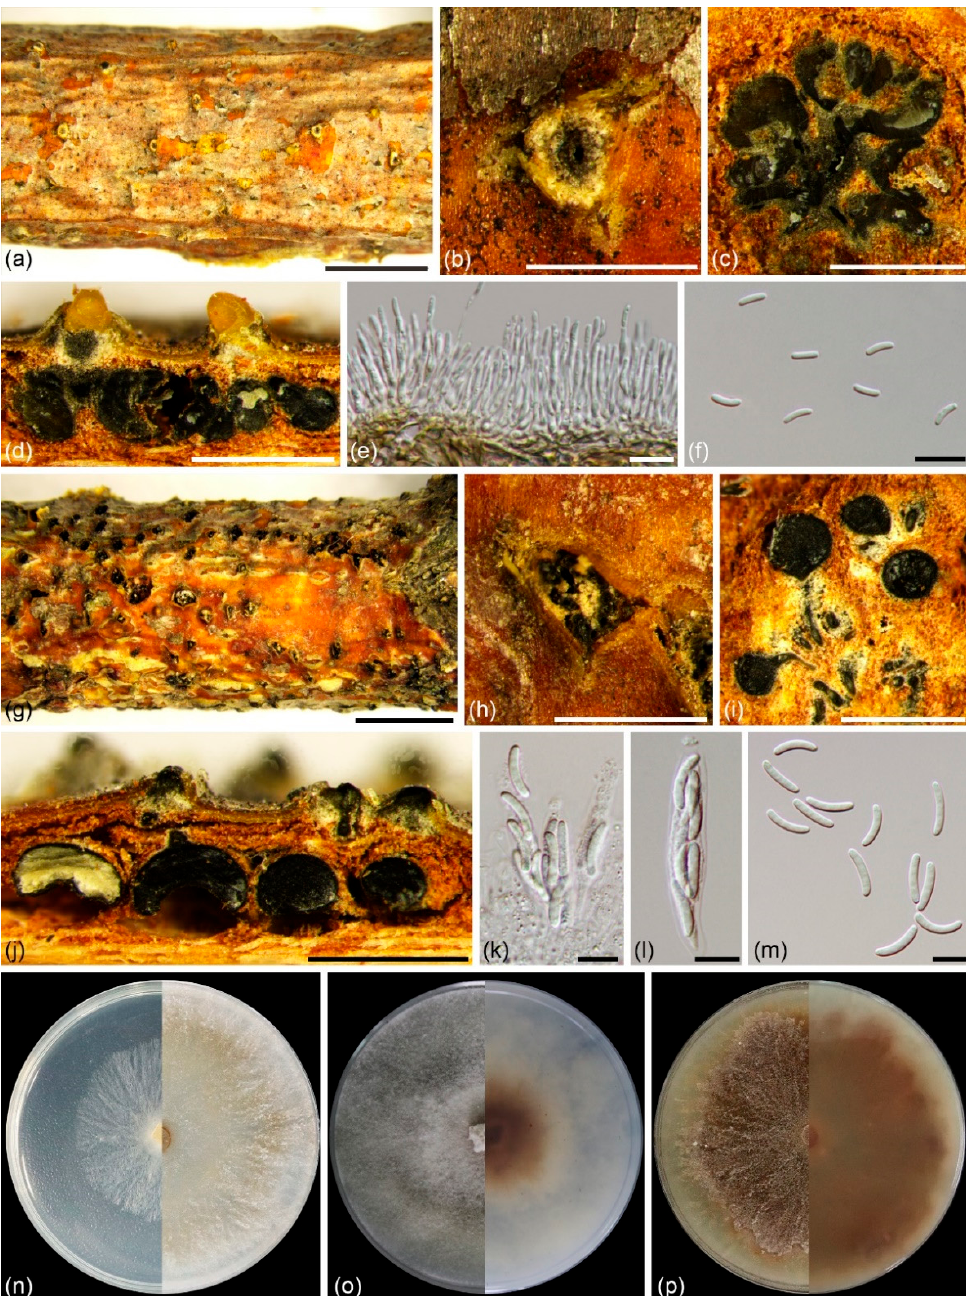
Figure 4. Cytospora paracinnamomea (BJFC CF20201003) from Salix matsudana : ( a , b ) habit of conidio- mata on twig; ( c ) transverse section of conidioma; ( d ) longitudinal section through conidiomata; ( e ) conidiophores and conidiogenous cells; ( f ) conidia; ( g , h ) habit of ascomata on twig; ( i ) transverse section of ascoma; ( j ) longitudinal section through ascomata; ( k , l ) asci; ( m ) ascospores. Scale bars: 5 mm ( a , g ); 1 mm ( b – d , g , h ); 10 µ m ( e , f , k – m ). Cultures on PDA ( n – p , CFCC 55453): ( n ) 2 days at left and 7 days at right; ( o ) 14 days, front side at left and back side at right; ( p ) 30 days, front side at left and back side at right.